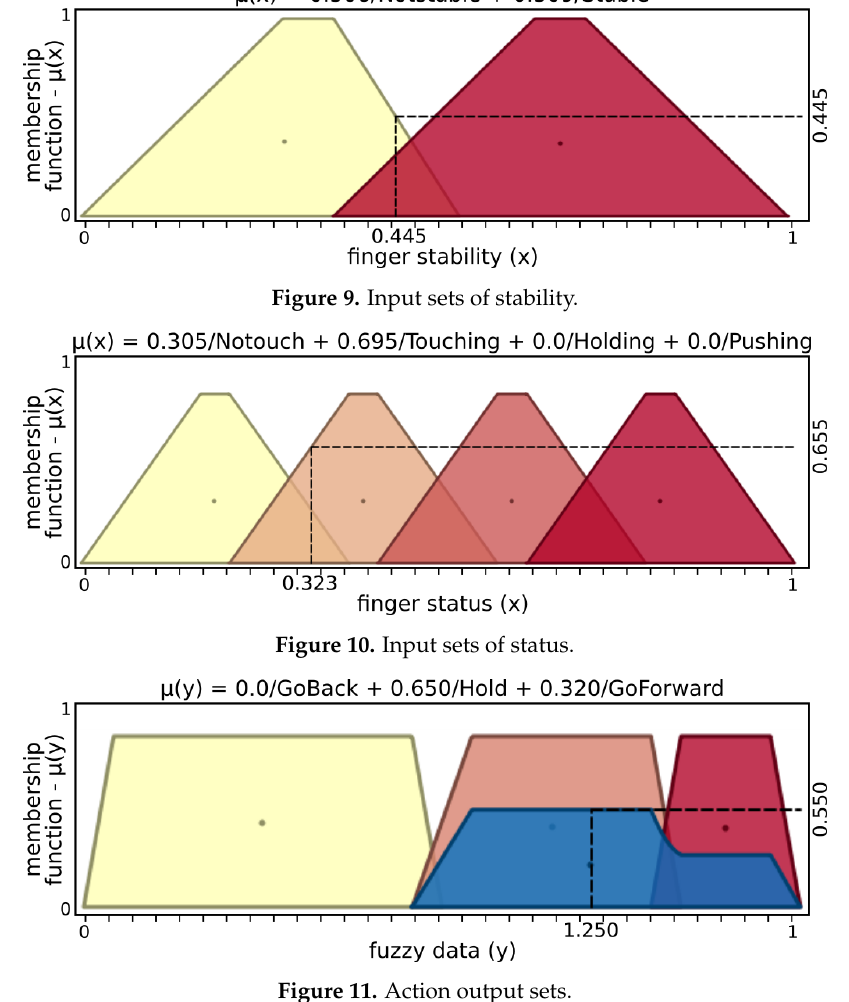
Figure 11. Action output